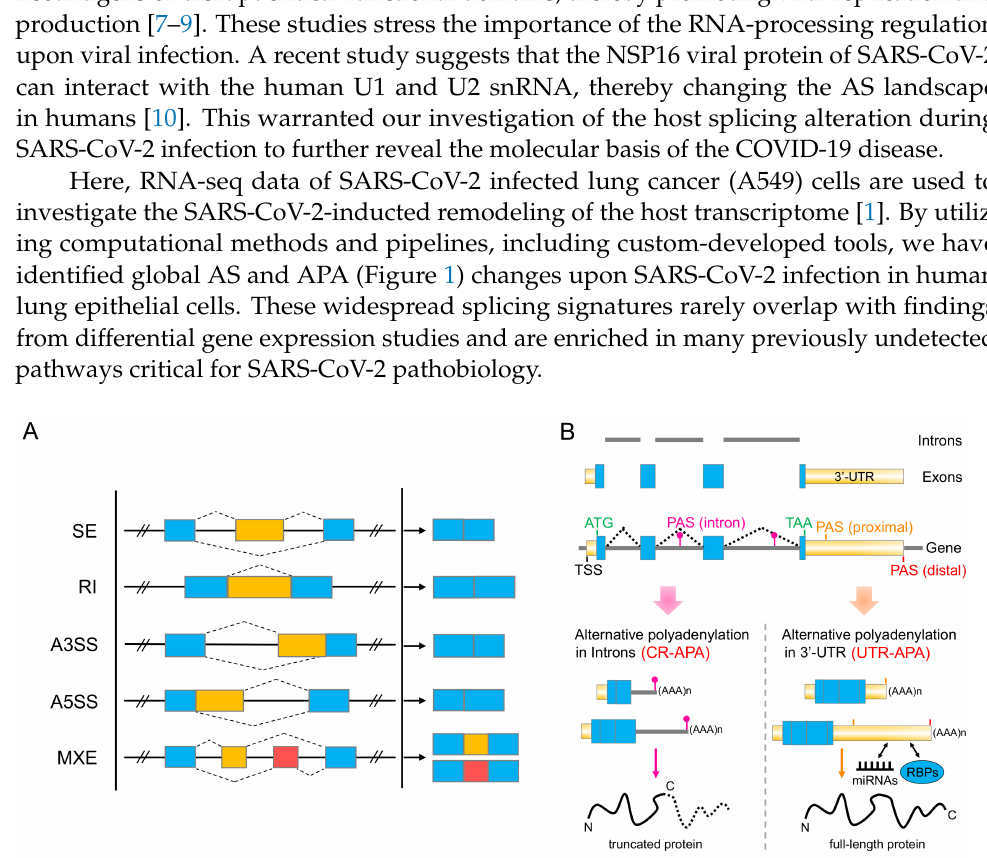
Figure 1. Alternative splicing (AS) and alternative polyadenylation (APA). ( A ) Schematic represen- tation of the five major types of alternative splicing in eukaryotes: Skipped Exon (SE), Retained Intron (RI), Alternative 3 (cid:48) Splice Site (A3SS), Alternative 5 (cid:48) Splice Site (A5SS), and Mutually Exclu- sive Exon (MXE). Light blue boxes represent the constitutive exons, whereas light yellow and pink exons represent the spliced ones. ( B ) Two types of alternative polyadenylation, i.e., coding region alternative polyadenylation (CR-APA) and 3 (cid:48) -UTR alternative polyadenylation (UTR-APA), and their impact on the functional proteome. PAS: polyadenylation signal; TSS: transcription start site; RBP: RNA-binding